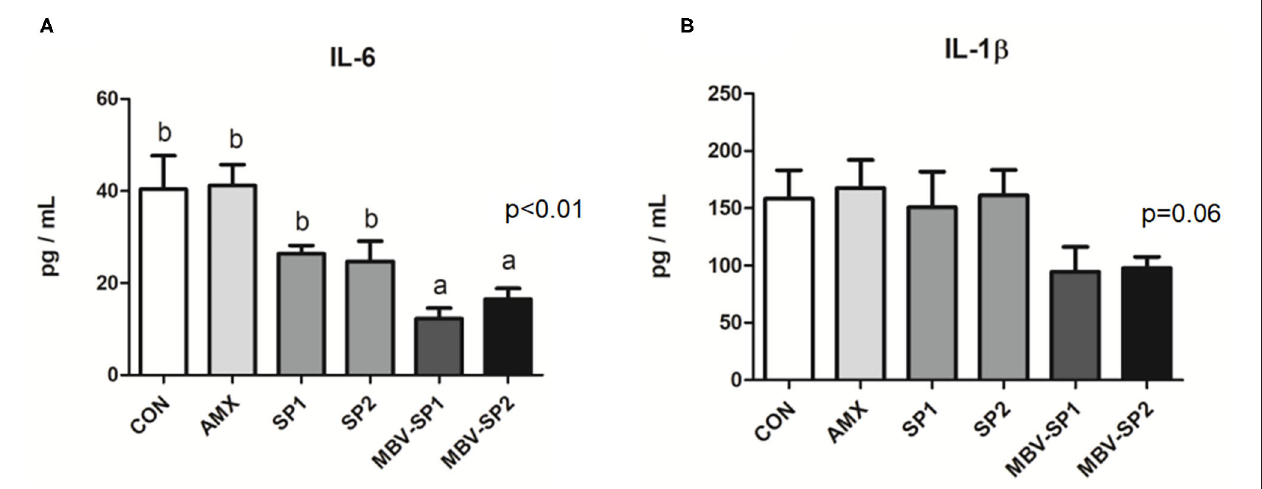
FIGURE 5 | Enzyme-linked immunosorbent assay of IL-6 (A) and IL-1 beta (B) in chicken plasma after feeding with basal diet (CON), AMX, SP1, SP2, MBV-SP1, and MBV-SP2. Data were presented as mean ± S.D. and subjected to one-way ANOVA. The mean differences were compared using Tukey’s multiple comparison test. Different letters indicate significant differences between treatments. Significance was declared when the probability was < 5% ( P < 0.05; n = 8/each